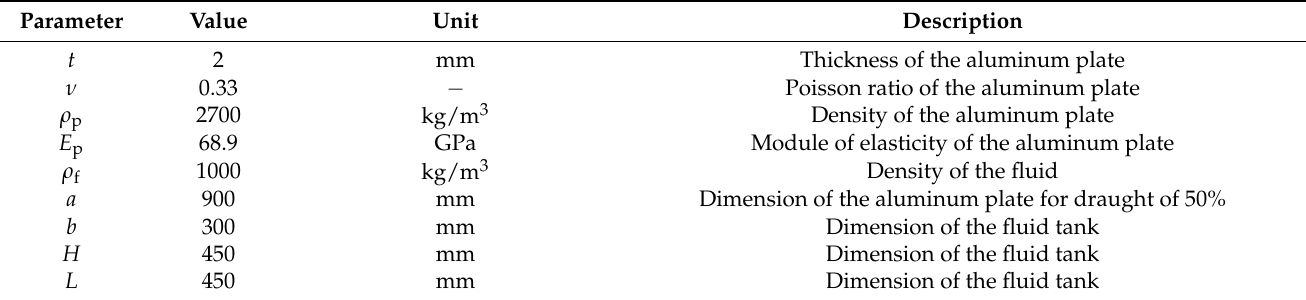
Figure 1. Schematic of the three-dimensional sloshing and structural vibrations front view. Table 1. Experimental setup parameters